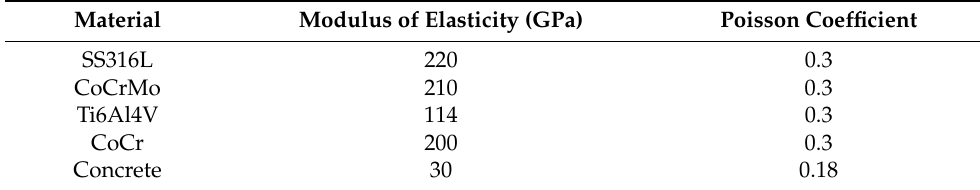
Table 2. Mechanical properties of the implants and the assembly components [1,11,29,49,50].